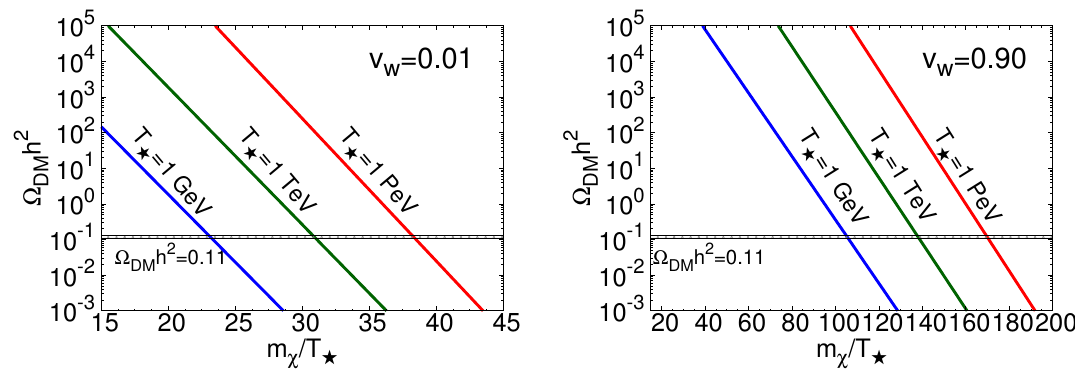
Figure 1 . The DM relic abundance after bubble filtering for non-relativistic and relativistic bubble wall